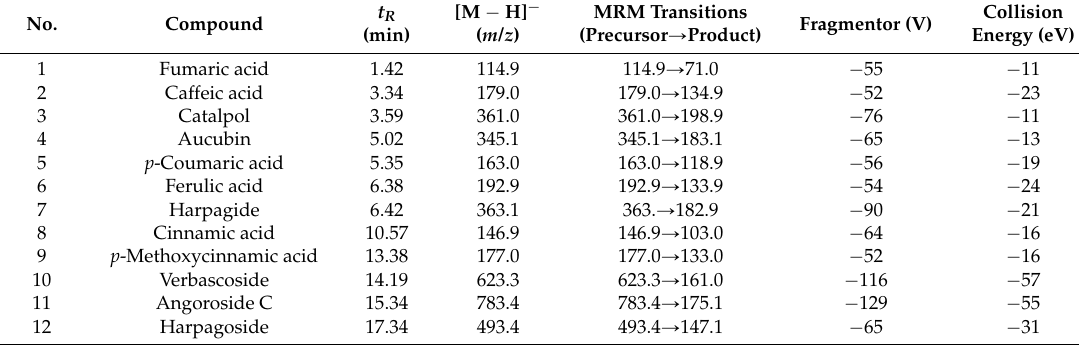
Table 1. Precursor/product ion pairs and parameters for MRM of compounds used in this study.